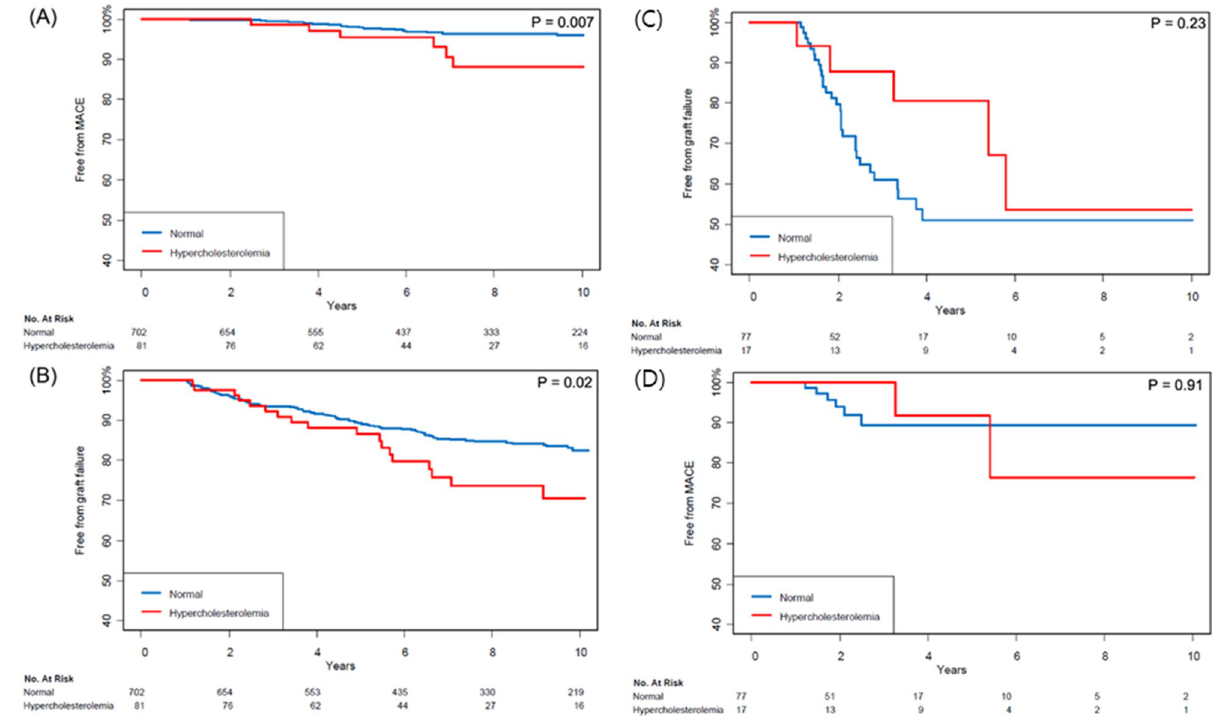
Figure 4. Kaplan–Meier curves for ( A ) major adverse cardiac event and ( B ) graft failure in recipients without the use of mechanistic target of rapamycin and ( C ) major adverse cardiac event and ( D ) graft failure in recipients with the use of mechanistic target of